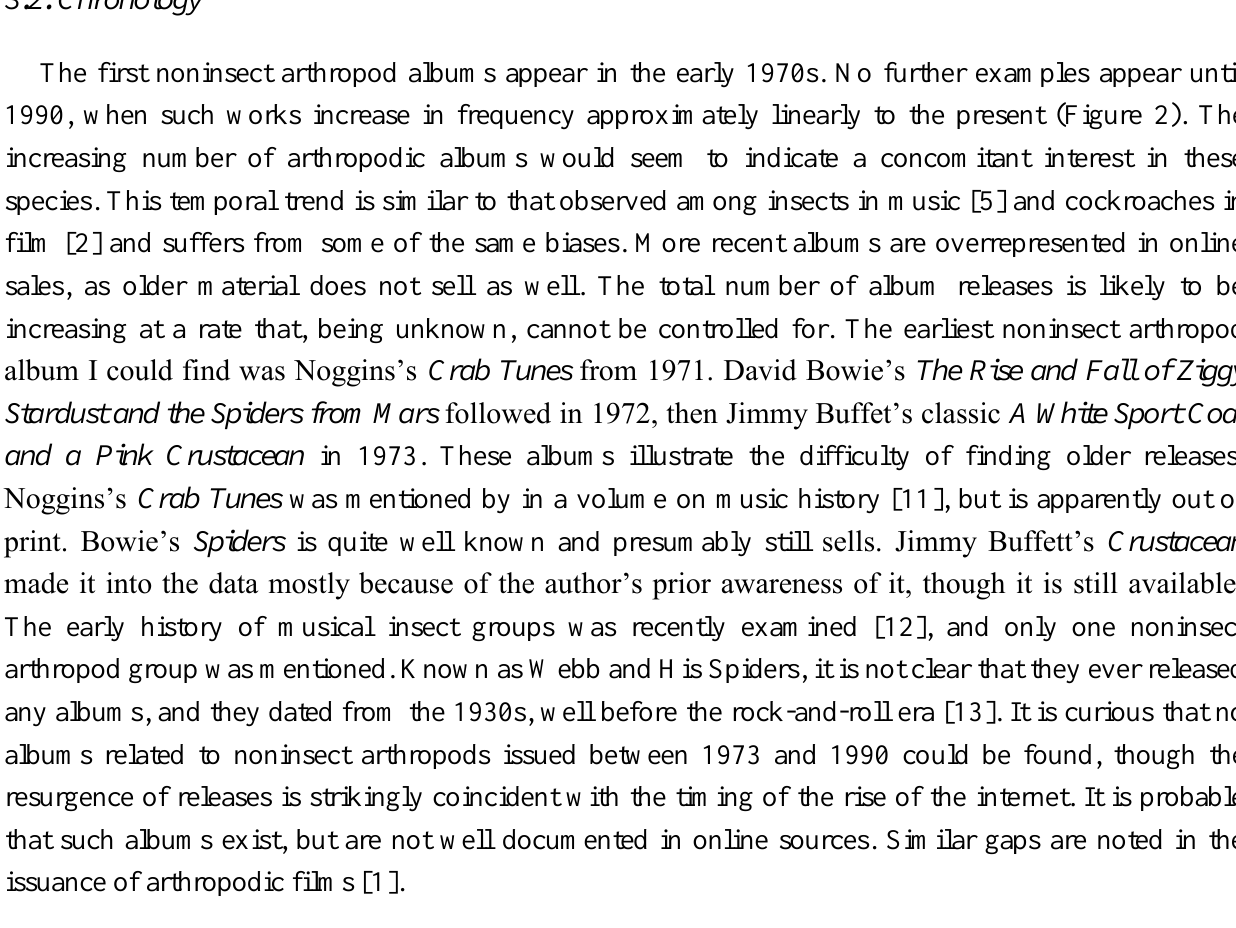
Figure 2. Number of noninsect arthropod albums released over